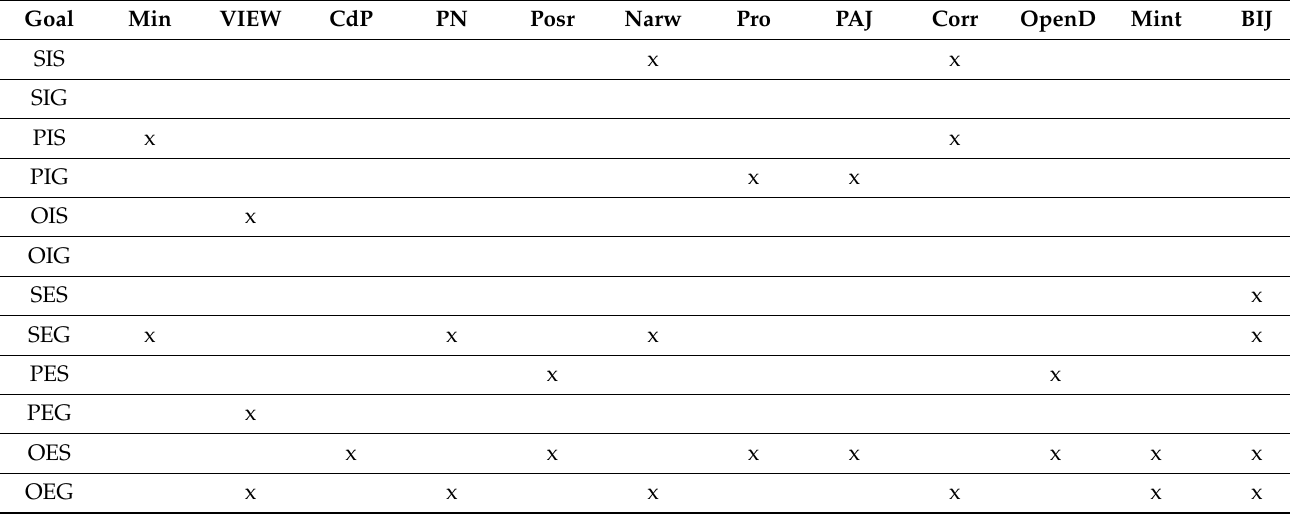
Table 1. The table shows the distribution, among the news organisations, of key rhetorical schemes in the mission statements or funding appeals, in the categories set out